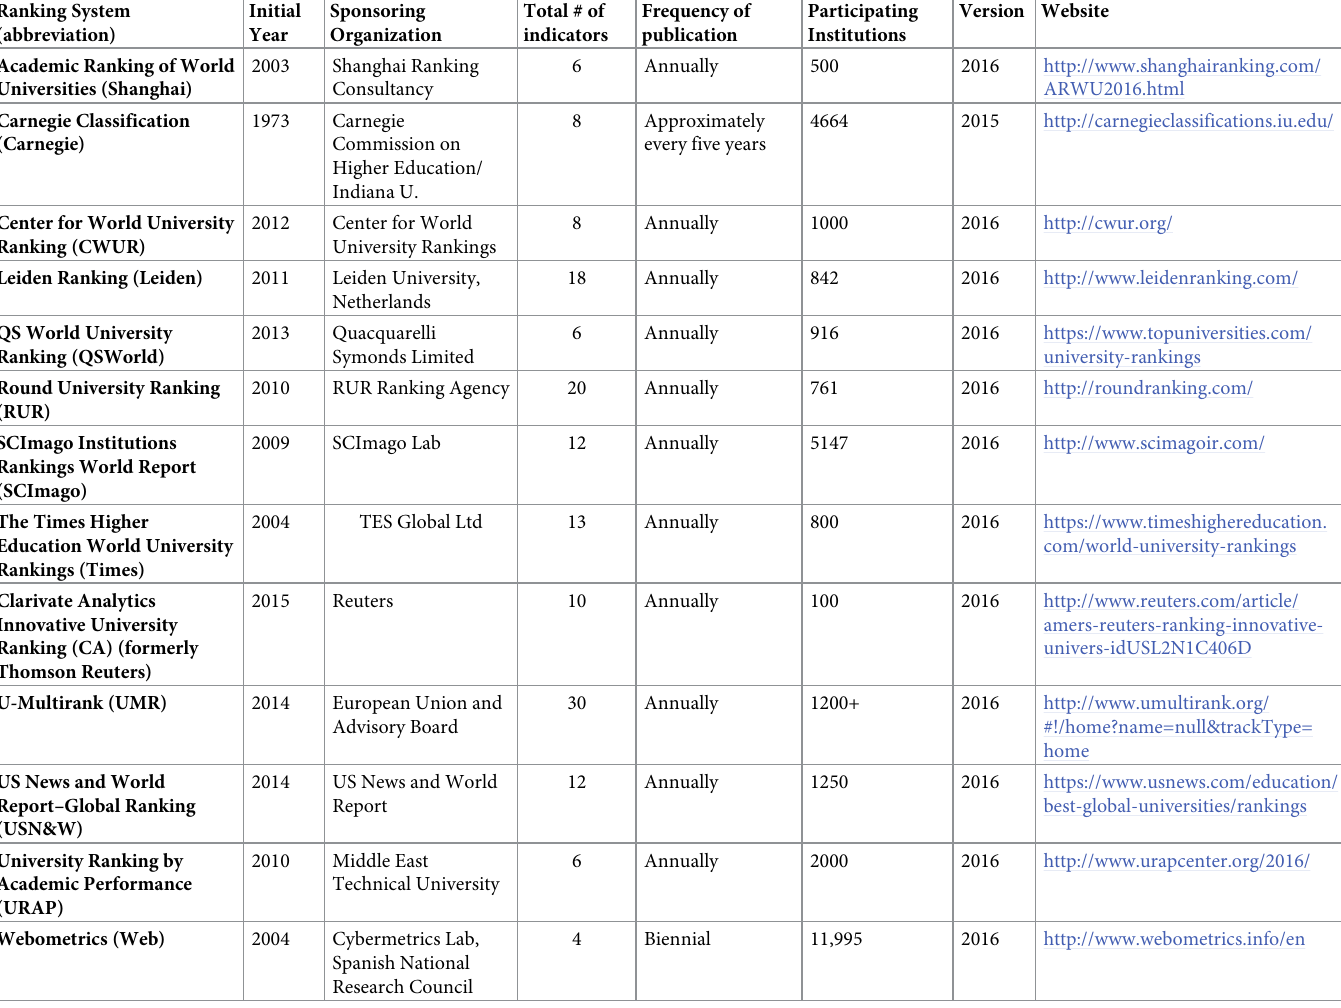
Table 1. University ranking systems.